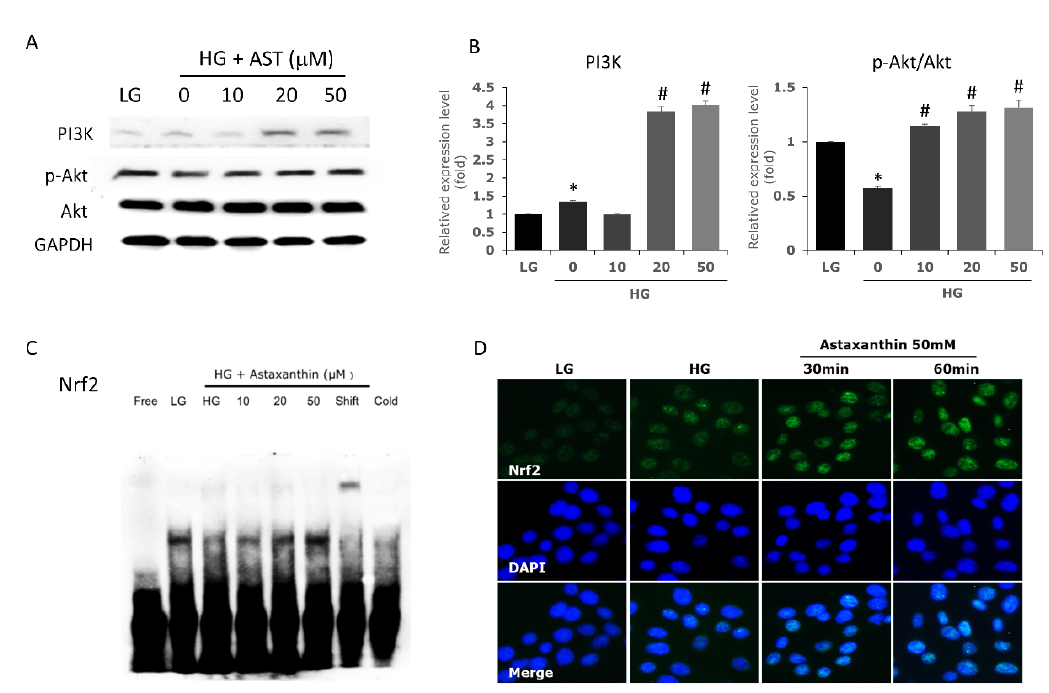
Figure 5. AST upregulates the expression of the PI3K / Akt / Nrf2 pathway in 661W cells. ( A , B ) The expression of PI3K and phosphorylated Akt proteins were detected by western blot. 661W cells were pretreated with di ff erent concentrations of AST for 2 h and grown in high glucose for 24 h. ( C ) Nrf2 levels in nuclear protein extracts were determined by electrophoretic mobility shift assay. ( D ) Immunocytochemistry confirmed the increased expression of Nrf2 after AST treatment. AST = astaxanthin; HG = high glucose; LG = low glucose. * Significantly di ff erent from control group ( p < 0.05); # significantly di ff erent from high glucose-treated group without AST ( p < 0.05). The Mann–Whitney U test was used to calculate the di ff erences between the means of di ff erent experimental groups.